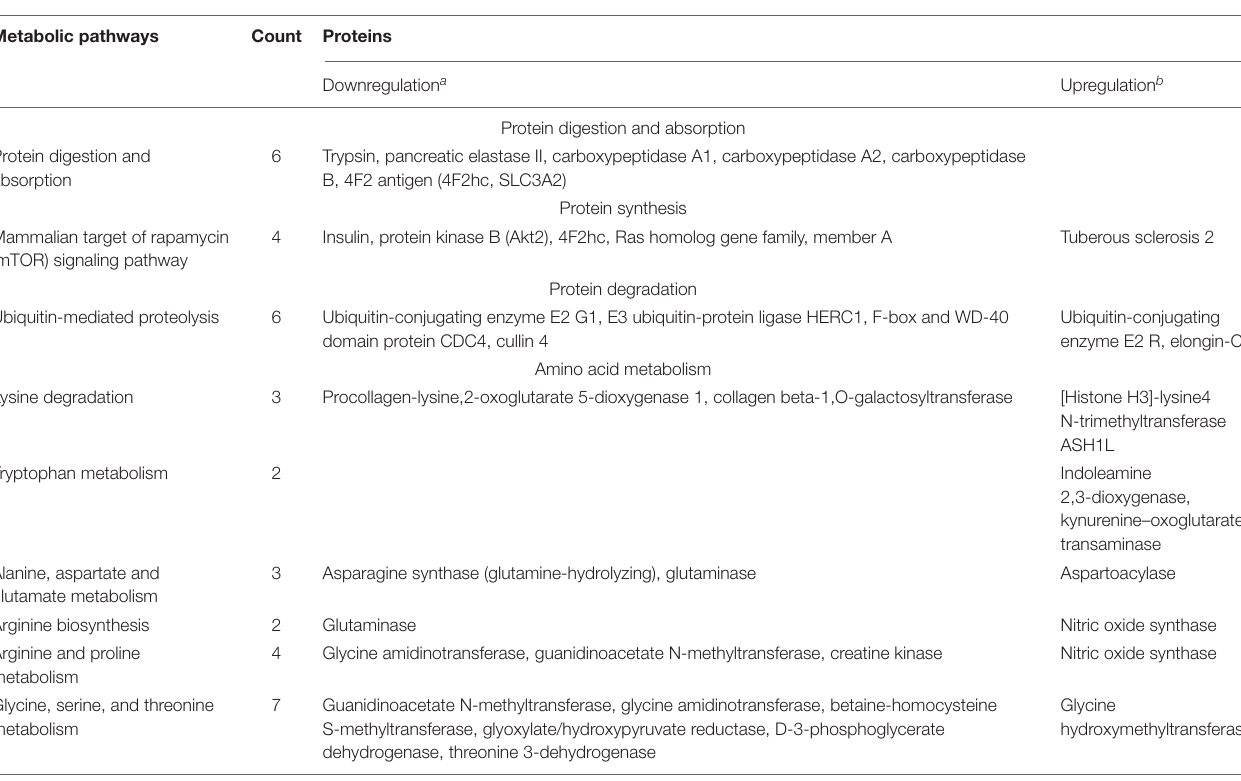
TABLE 5 | Key differential proteins and their pathways annotated by KEGG. Metabolic